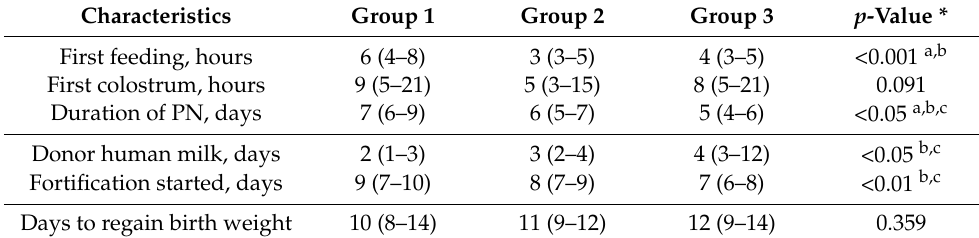
Table 2. Feeding characteristics of infants in different birth weight groups.